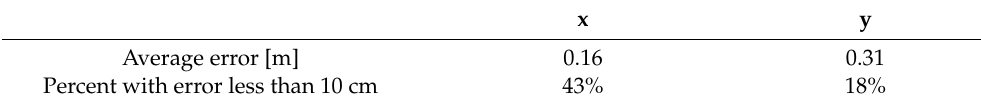
Table 3. Static accuracy test summary results.